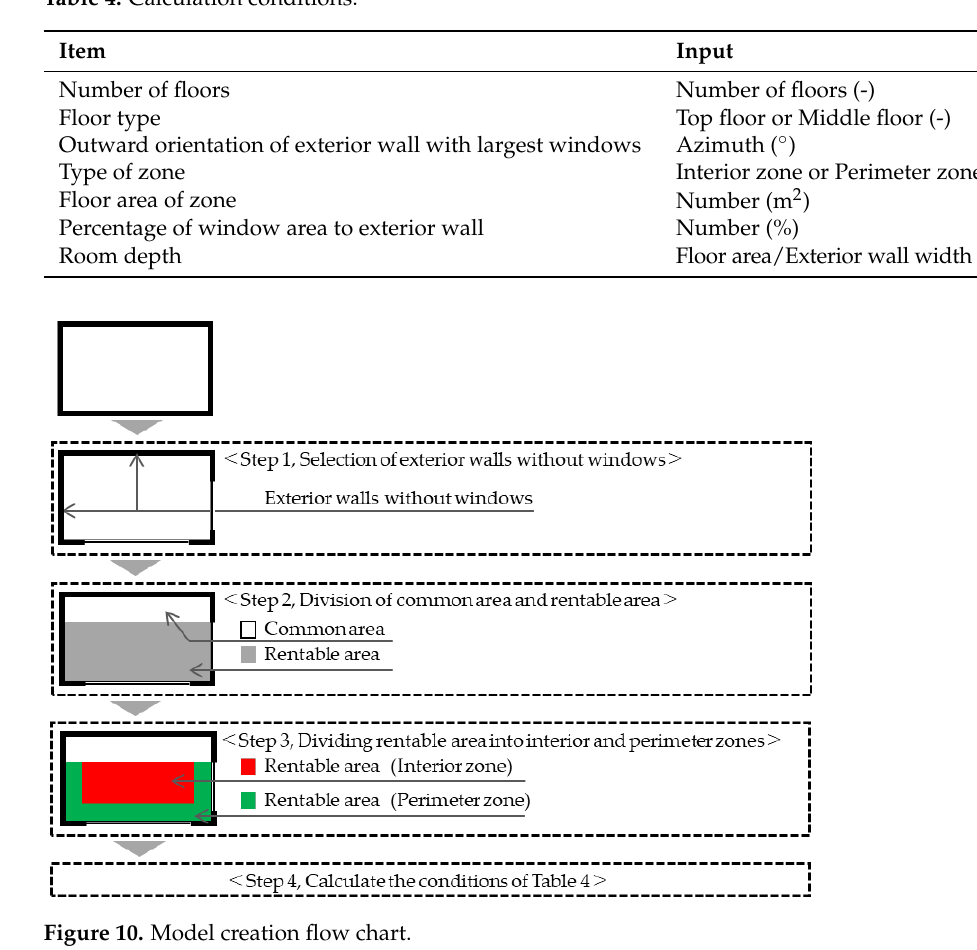
Table 4. Calculation conditions.